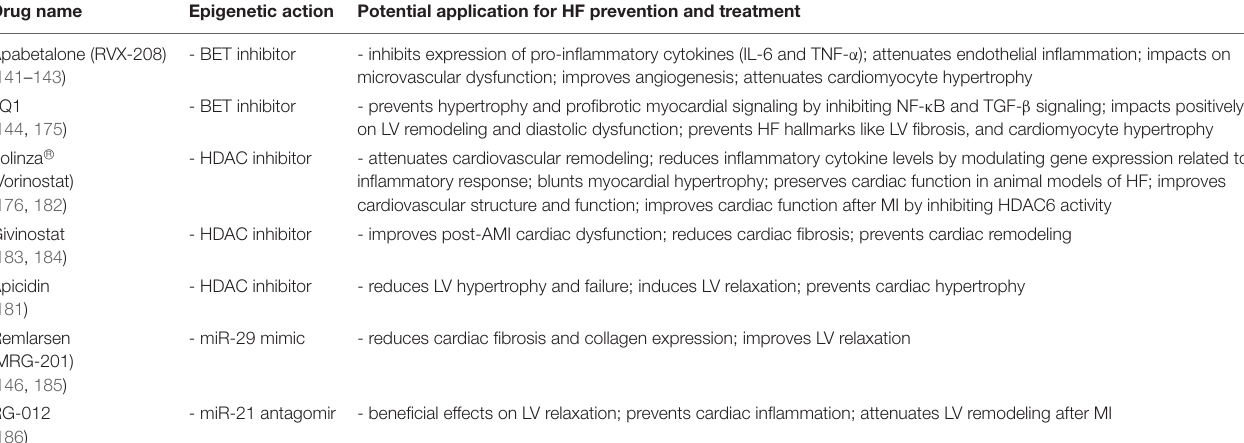
TABLE 3 | Epi-drugs with potential application in heart failure. Drug